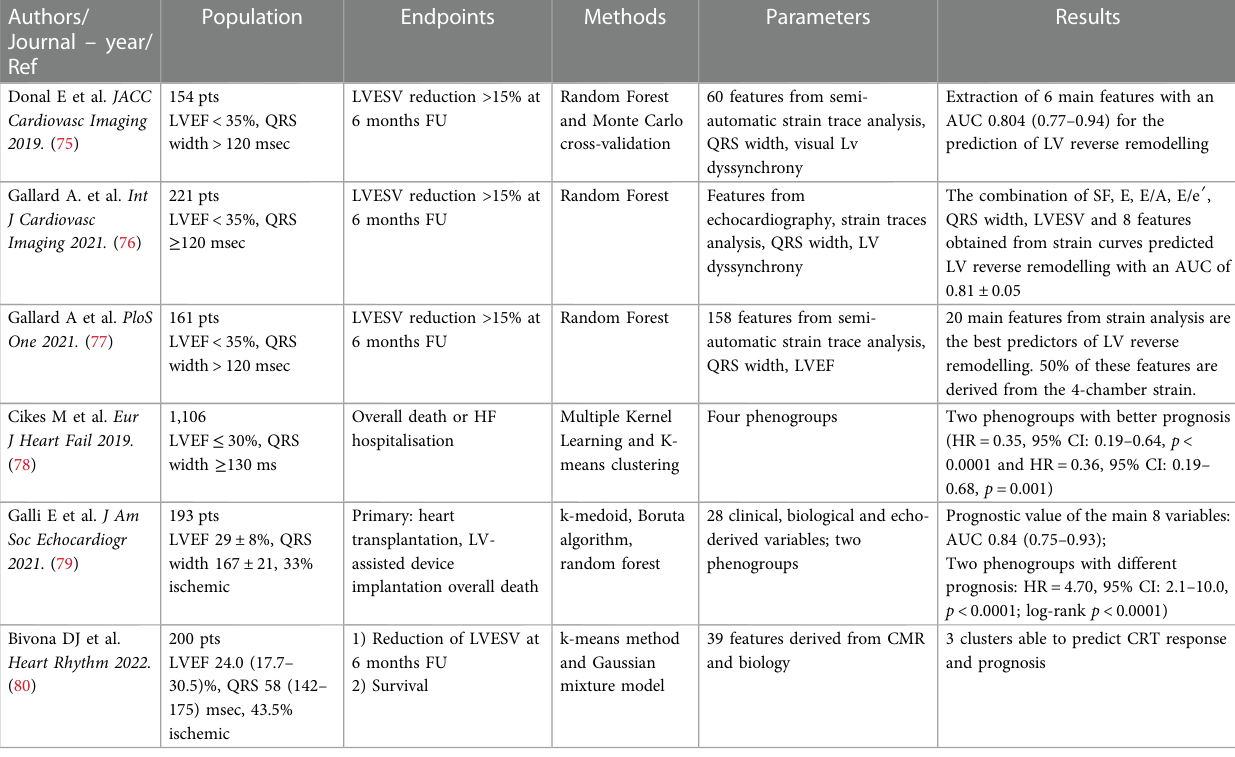
TABLE 2 Summary of the main cited studies providing an overview of the role of machine learning in the fi eld of CRT.